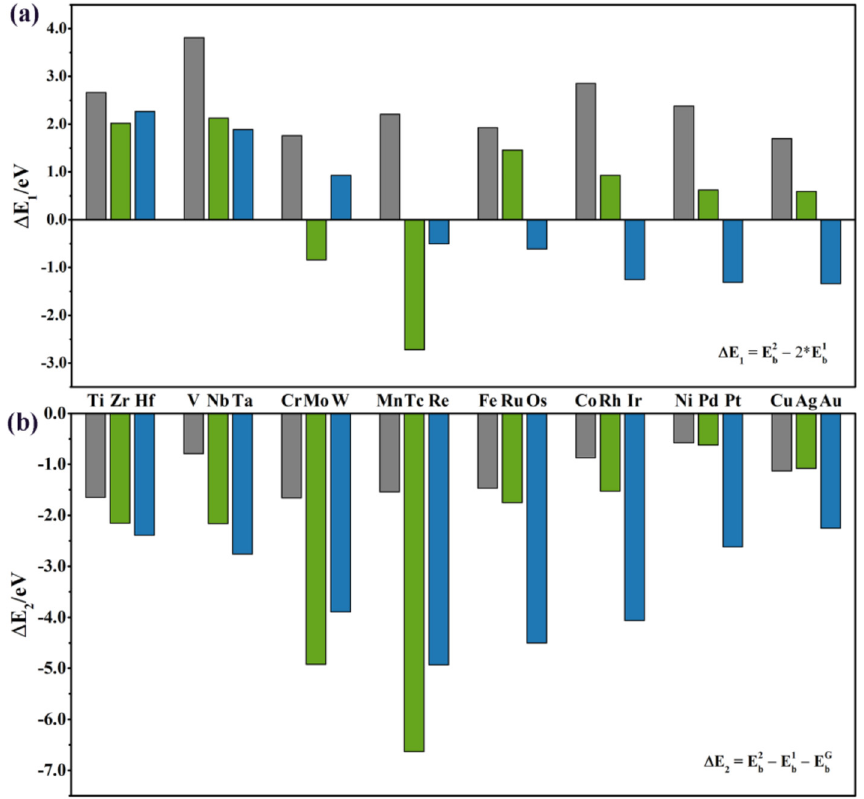
Figure 4. ( a ) ∆𝐸 (cid:2869) is the difference between 𝐸 (cid:3029)(cid:2870) and 2 ∗ 𝐸 (cid:3029)(cid:2869) . ( b ) ∆𝐸 (cid:2870) is the difference be- tween ∆𝐸 (cid:2870) and ( 𝐸 (cid:3029)(cid:2869) (cid:3397) 𝐸 (cid:3029)(cid:3008) ). (gray, green, and blue histograms represent for 3d, 4d, and 5d TM elements, respectively.)